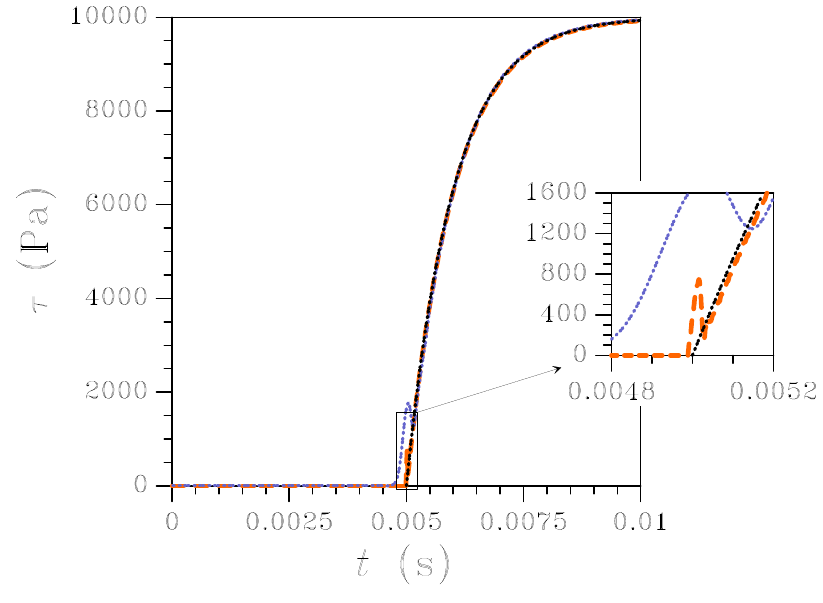
Figure 13. Wave propagating along an interface-containing homogeneous rod ( E N/m 3 ) discretized with one-dimensional and two-dimensional unstructured meshes: evolu- tion in time of the normal traction τ at the interface. Black dotted line: analytical solution; orange dashed line: one-dimensional FCT-FE solution; blue dotted line: two-dimensional FCT-FE